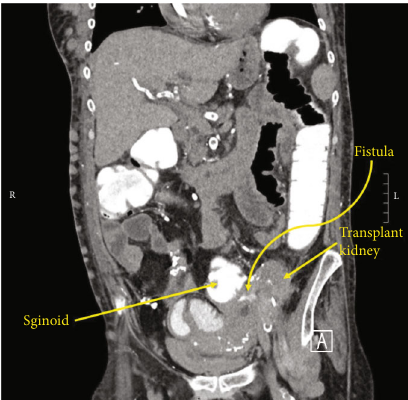
Figure 2: Sagittal CT of the abdomen and pelvis with rectal contrast demonstrating fi stulous connection between the sigmoid colon and left renal transplant